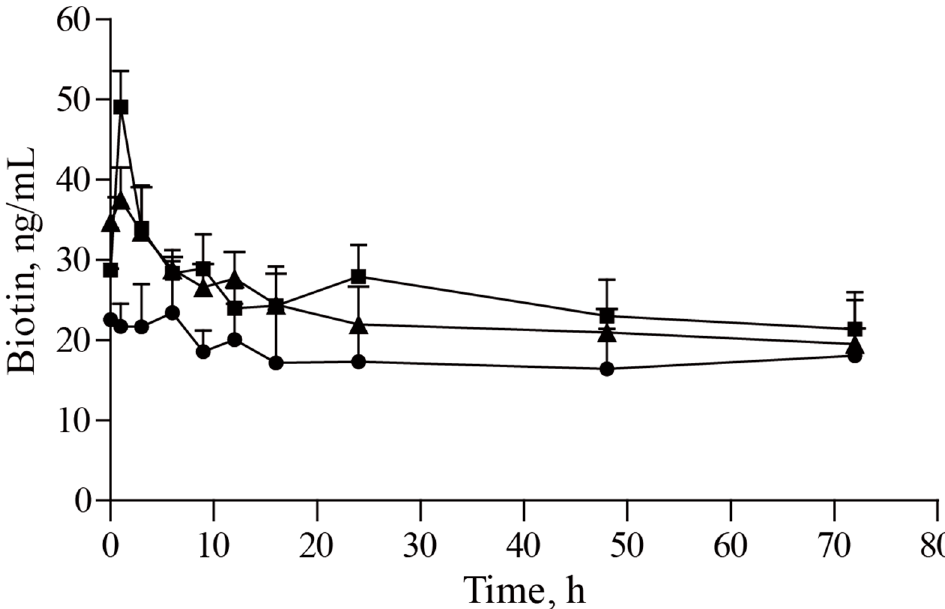
Figure 9. The plasma concentration of biotin versus time. The concentration of biotin in plasma from 0 to 72 h after oral placebo ( ● ), non-microencapsulated vitamin supplement ( ▪ ), and microencapsulated vitamin supplement ( ▲ ), respectively. Error bars represent standard deviations.